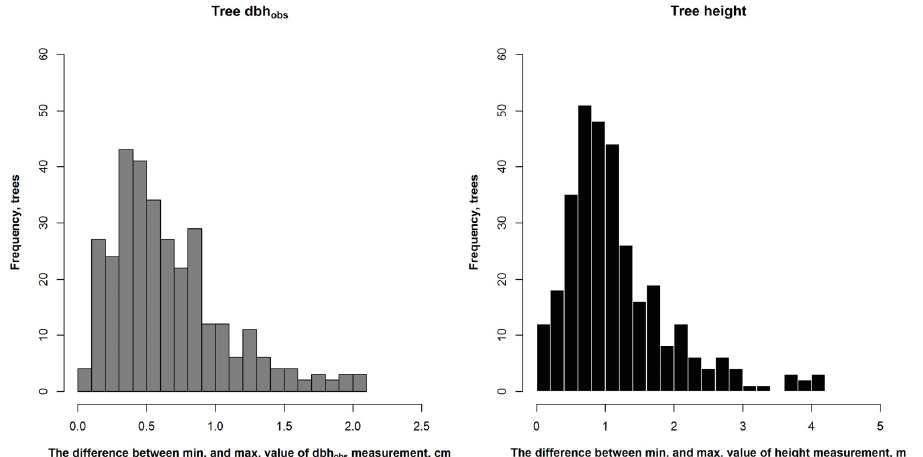
Figure 3. Histograms describing the frequency of largest difference among the sample tree measurements. On left: within the dbh obs (mean of cross measurements) measurements from the same tree. On right: within the tree height measurements from the same tree.